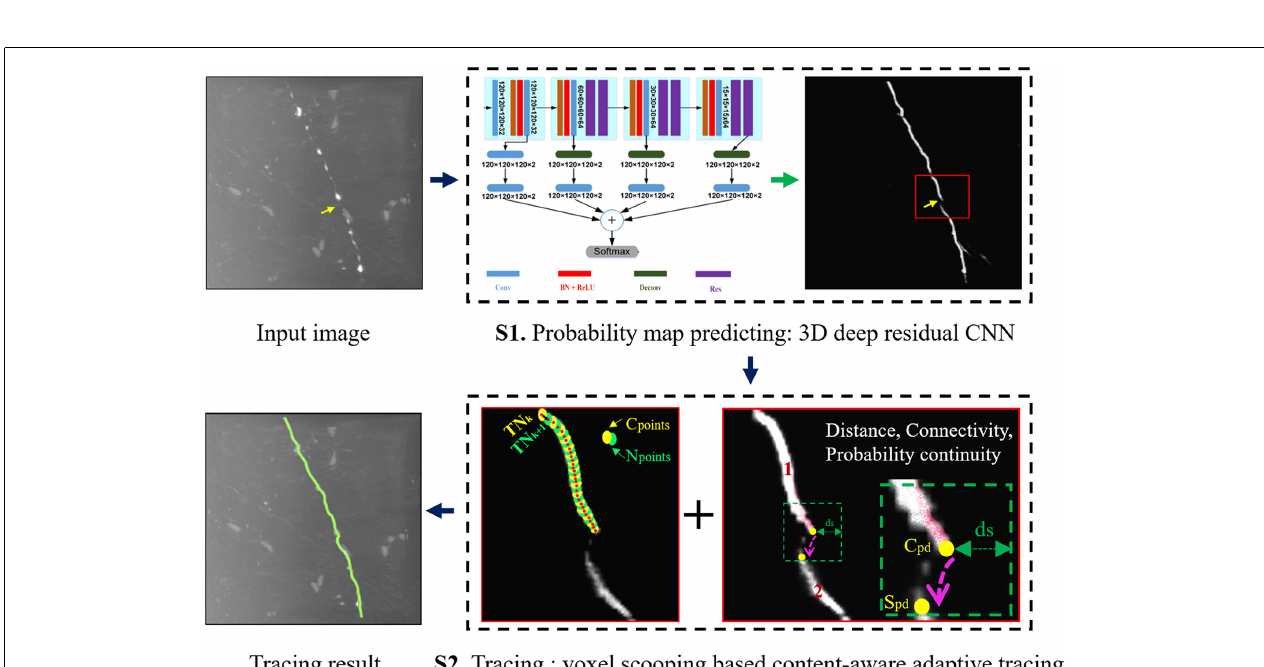
FIGURE 2 | Flowchart of the proposed neuron tracing